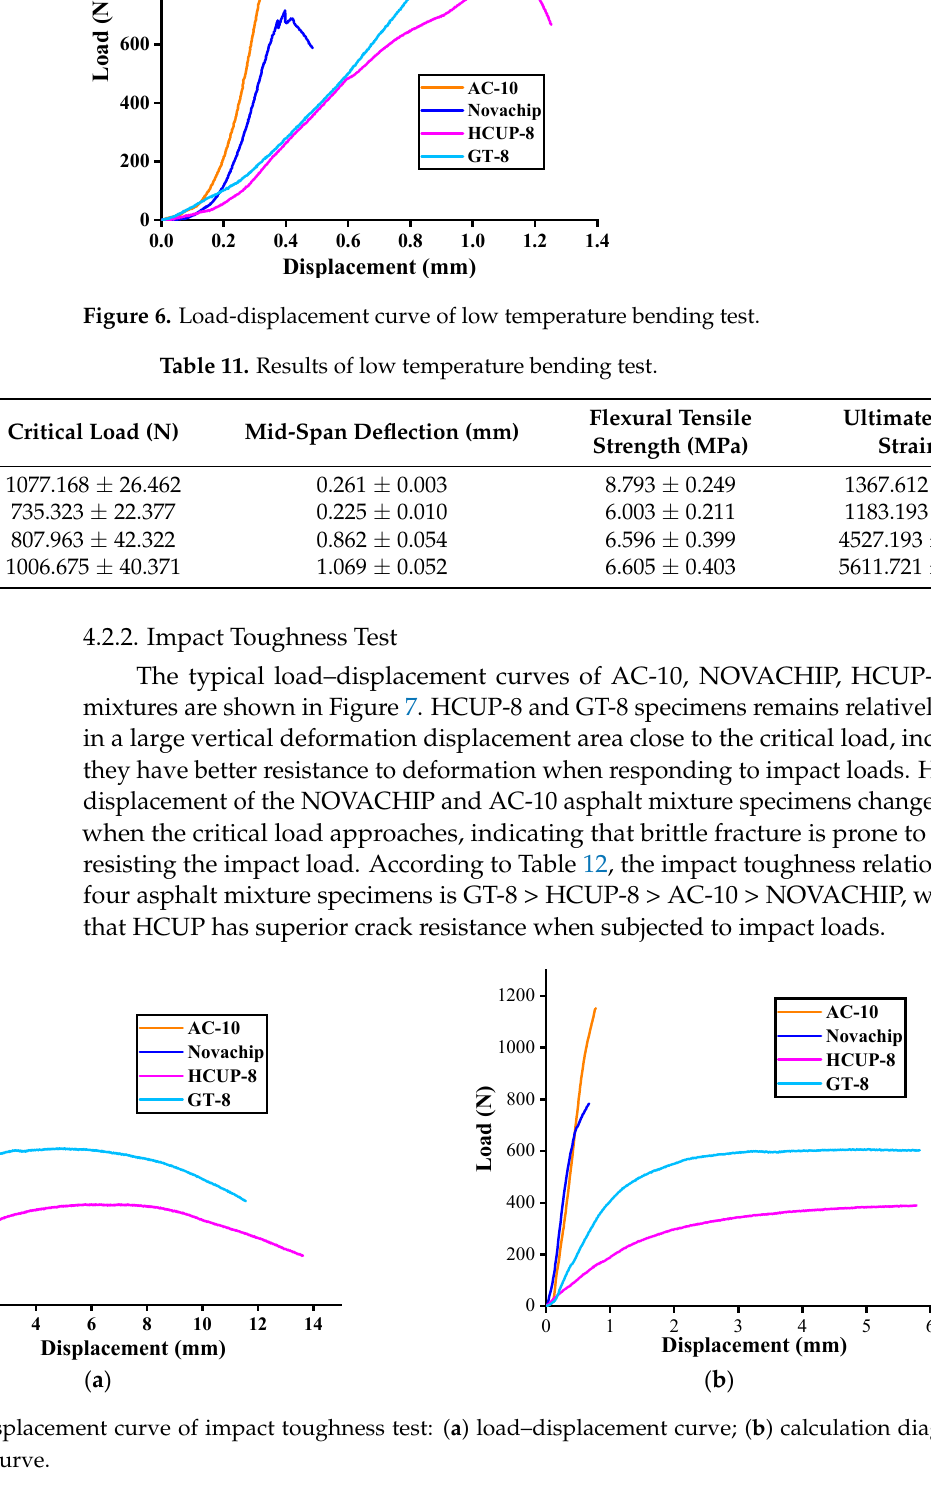
( b ) Figure 5. ( a ) Dynamic stability test; ( b ) scattering loss test and texture depth test. Table 10. Results of dynamic stability, scattering loss and texture depth. Mixture Type Dynamic Stability (Cycles/mm)